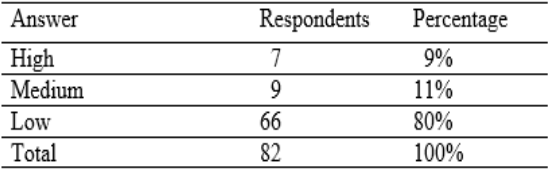
Table 4. Table of received answers to